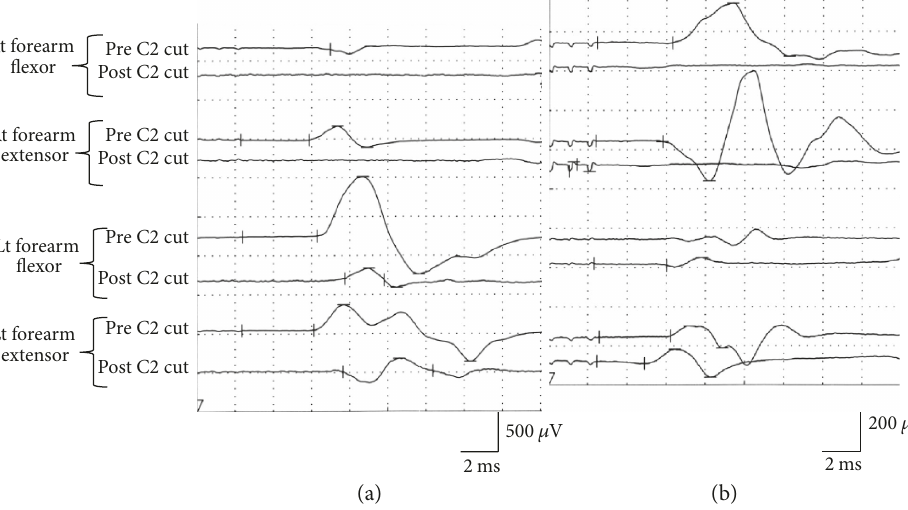
Figure 8: CMAPs (stimulation intensity: 2T) of rats having undergone additional right C2 hemisection. (a) Immediately after right C2 hemisection, electric potential of the right forelimb was lost in response to the stimulation of the right pyramid, whereas the electric potential of the left forelimb was not lost although the waveform amplitude decreased. (b) Immediately after right C2 hemisection, electric potential of the right forelimb was lost in response to the stimulation of the left pyramid, whereas the electric potential of the left forelimb was not lost although the waveform amplitude decreased.